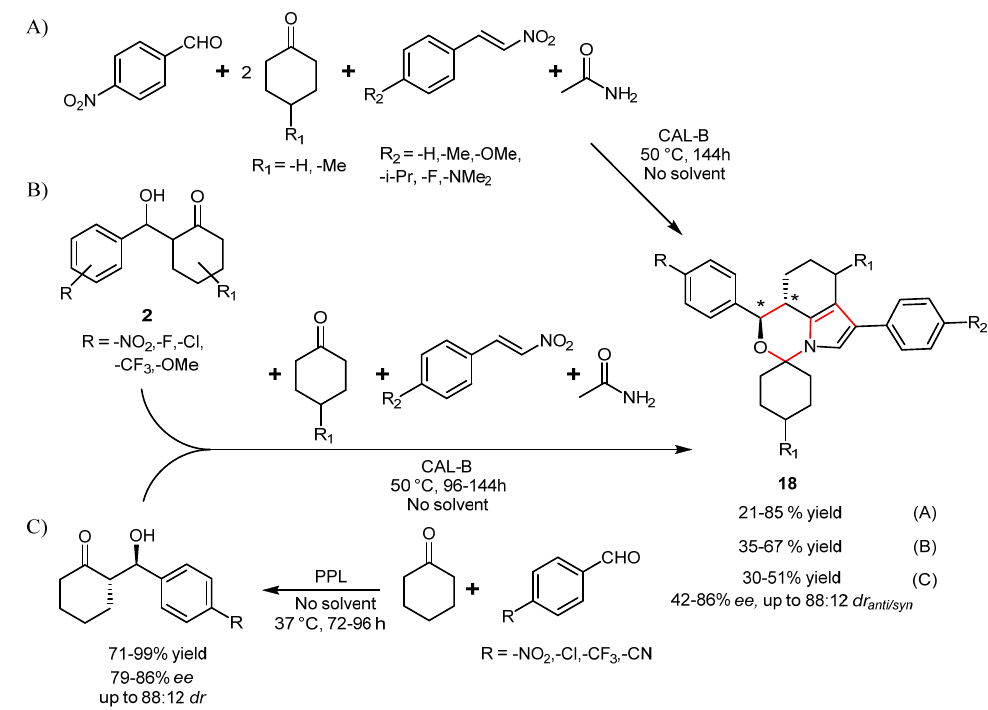
Scheme 21. Alternative routes for the synthesis of spirooxazines catalyzed by lipase